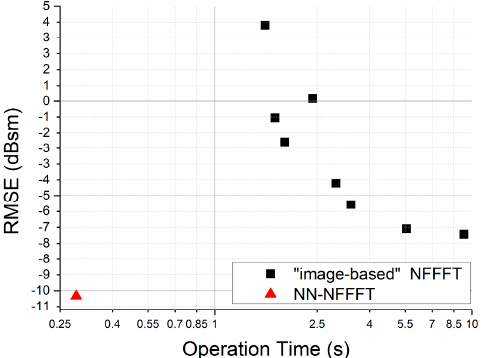
Figure 9. The RMSE vs. operation time of “Image-Based” NFFFT and NN-NFFFT.